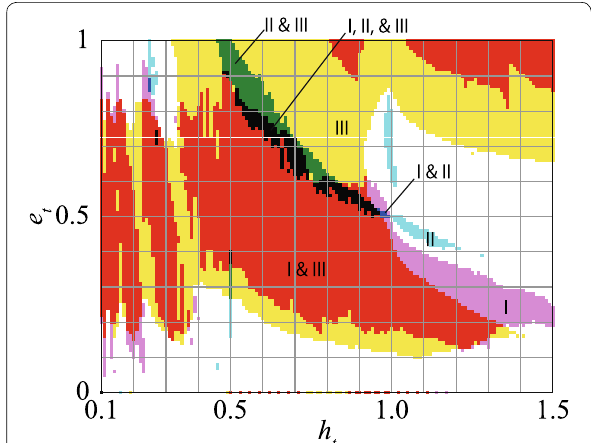
Fig. 6 The stability field for all combinations of the modes for CM (Fig. 5). Purple: Mode I, Cyan: Mode II, Yellow: Mode III, Blue: Modes I and II, Green: Modes II and III, Red: Modes I and III, Black: All